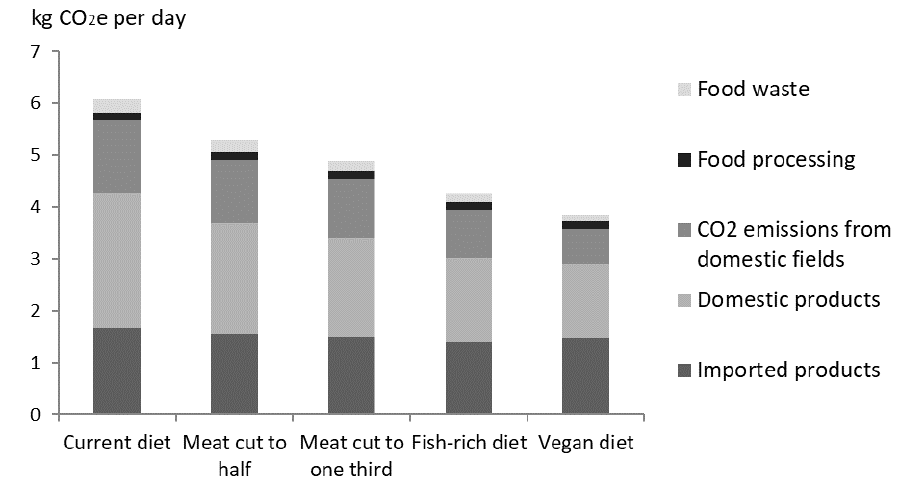
Fig. 2. Climate impact of the current diet and alternative diets, kg CO